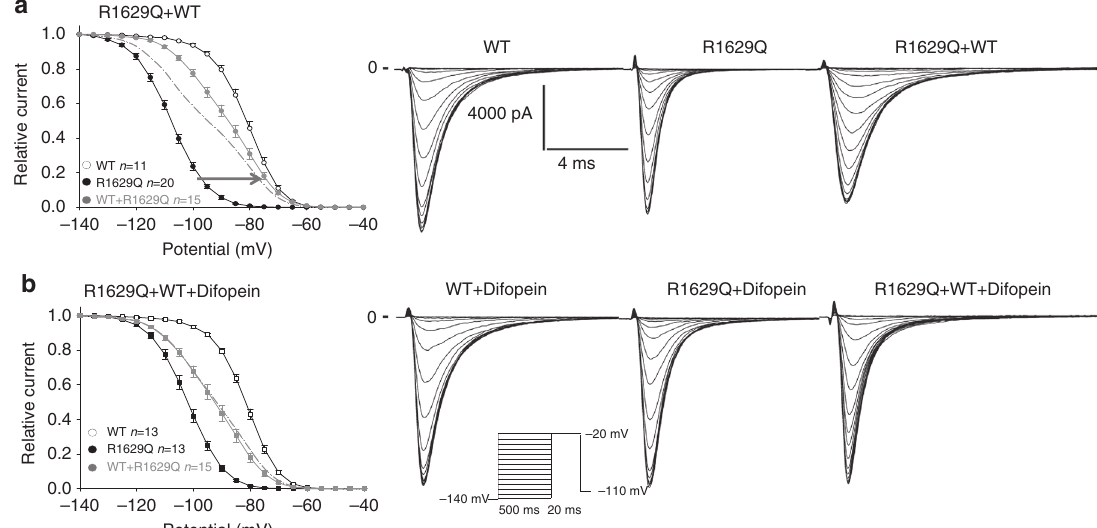
Fig. 5 Mutant channels display biophysical coupling with WT sodium channel. a Steady-state inactivation for the R1629Q mutant and WT expressed in HEK293 cells. The theoretical curve (dotted line) is obtained by averaging the WT and the R1629Q mutant curves together. The dotted line corresponds to the expected theoretical curve if each channel behaved independently. Data show that co-expression of the two channels together does not behave as expected for two independent channels (theoretical curve) and therefore suggests coupling of the two channels. b Steady-state inactivation of WT and R1629Q mutant in HEK293 cells in presence of the 14-3-3 inhibitor difopein. Data show that the steady-state inactivation in presence of difopein now behaves as the theoretical curve for independent channels. Data are presented as mean ± SEM. Right panel displays representative current recordings for each conditions